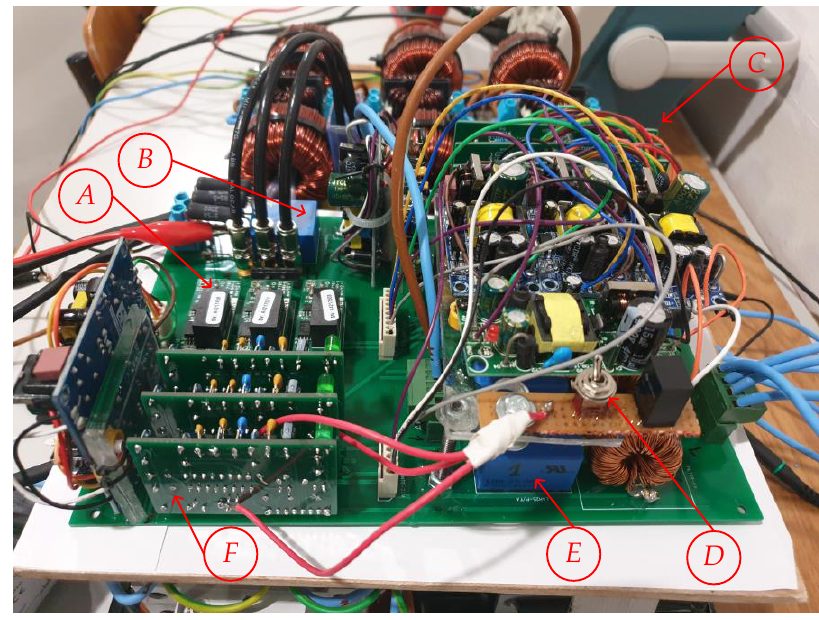
Figure 9. Prototype interface and control circuits.